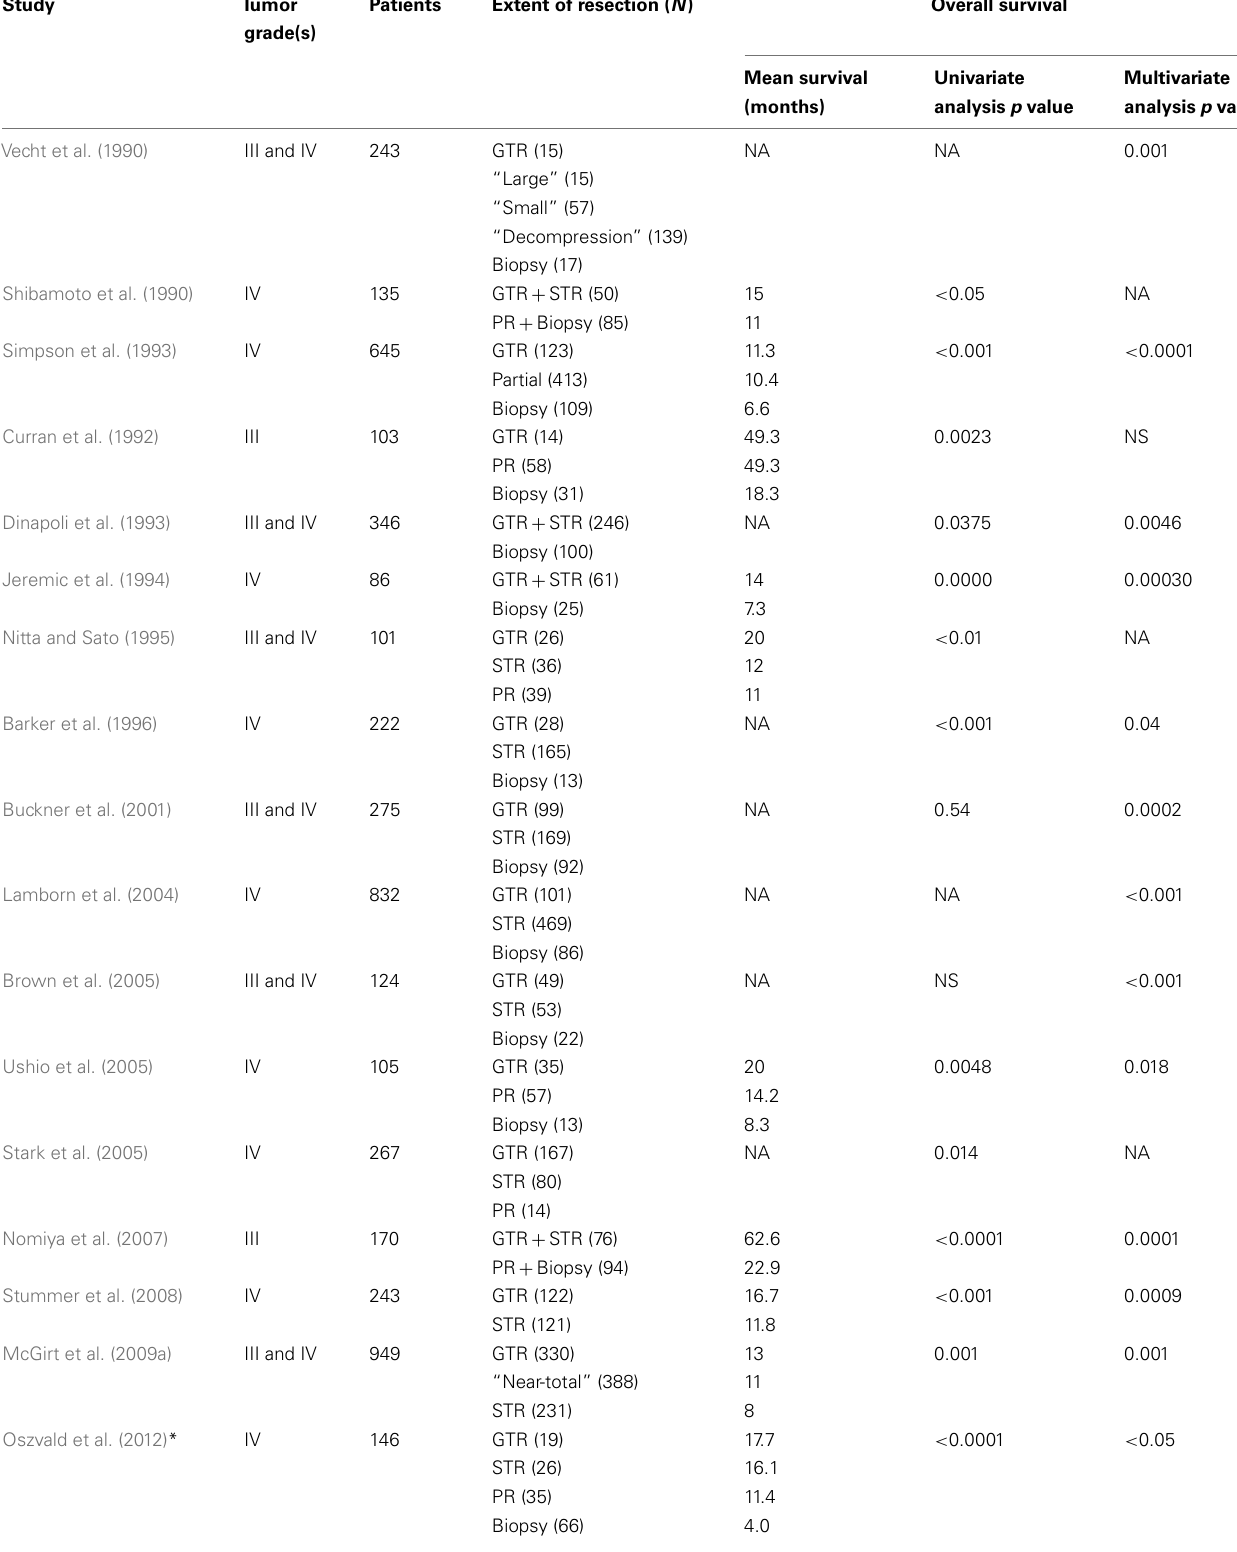
Table 2 | Positive, non-volumetric studies of EOR in high-grade